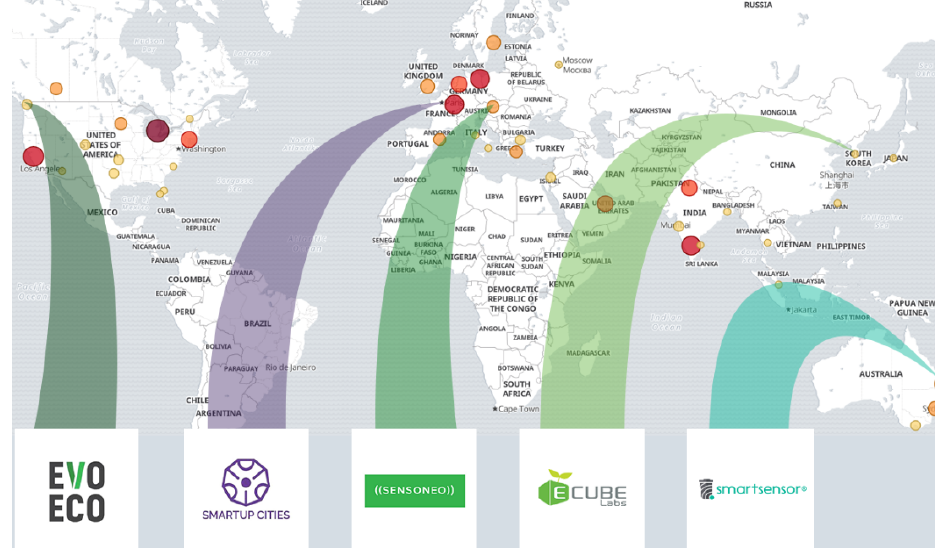
Figure 5. Global diaspora of businesses active in smart bin